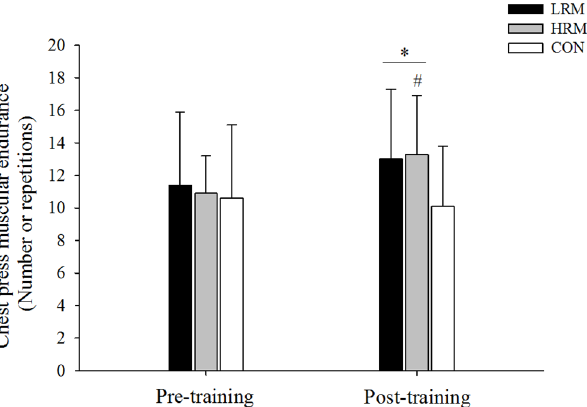
Fig 3. Mean ± SD of chest press muscular endurance pre and post 9 week of resistance training. LRM, heavy load – low repetition maximum resistance training group. HRM, moderate load – high repetition maximum resistance training group. CON, control group. ( * ) p < 0.05, higher than pre training. (#) p < 0.05, higher than CON group.